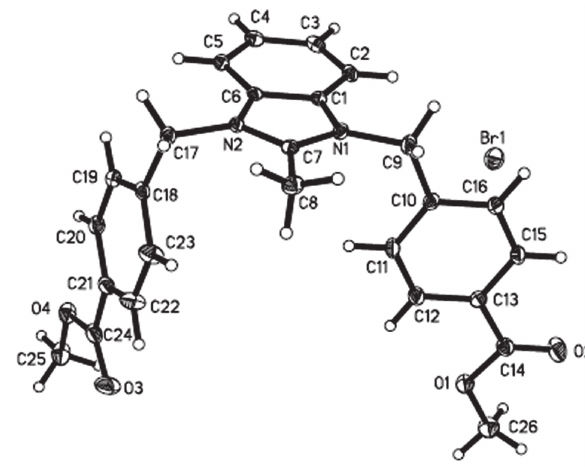
Table 1: Data collection and handling.